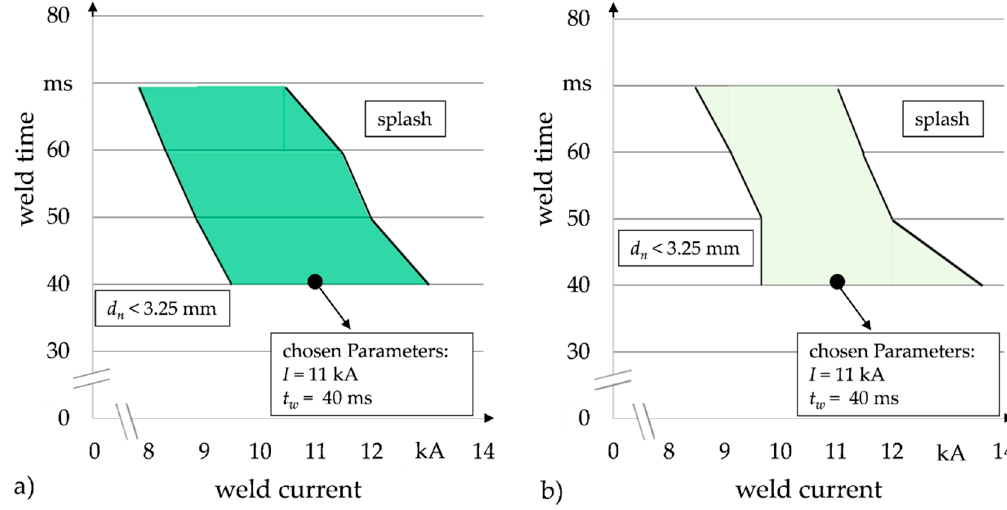
Figure 9. Simulative generated weldability lobes for weld insert type A ( a ) and type B ( b ).